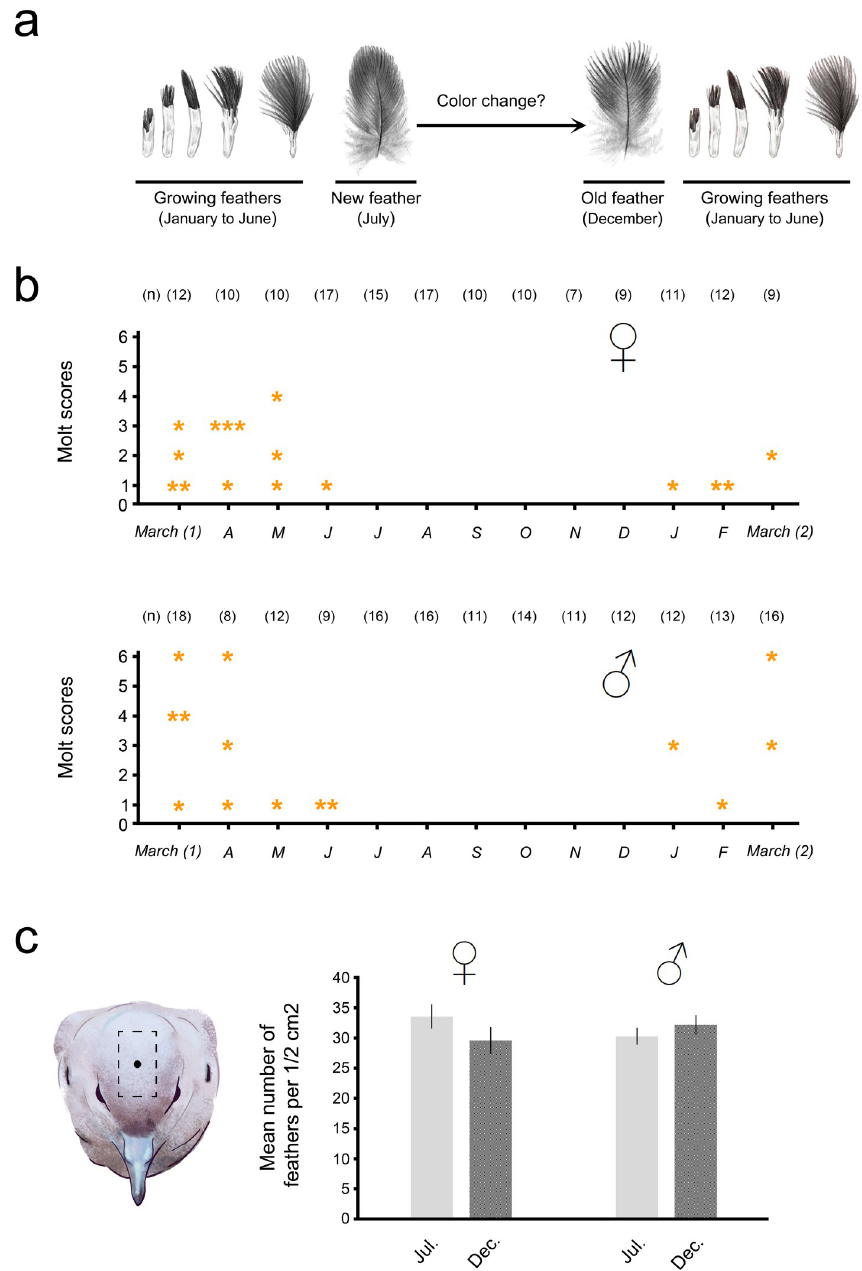
Fig 1. Molting period of the crown in the Eared Dove. a) Molting process of crown feathers in the Eared Dove. b) Molting period in both sexes of the Eared Dove and molt scores in each month, � indicates 1 bird, (n) Number of doves in each month c) On the left, graphic representation of the area (dotted line rectangle) of the crown where the number of feathers in females and males was measured. The dark dot in the center of the crown indicates where the spectrophotometric data was recorded. On the right, the mean number of feathers in ½ cm 2 of crown at two different times, winter (July) and spring (December), in both sexes. Data are expressed as mean ± SE and no significant differences were